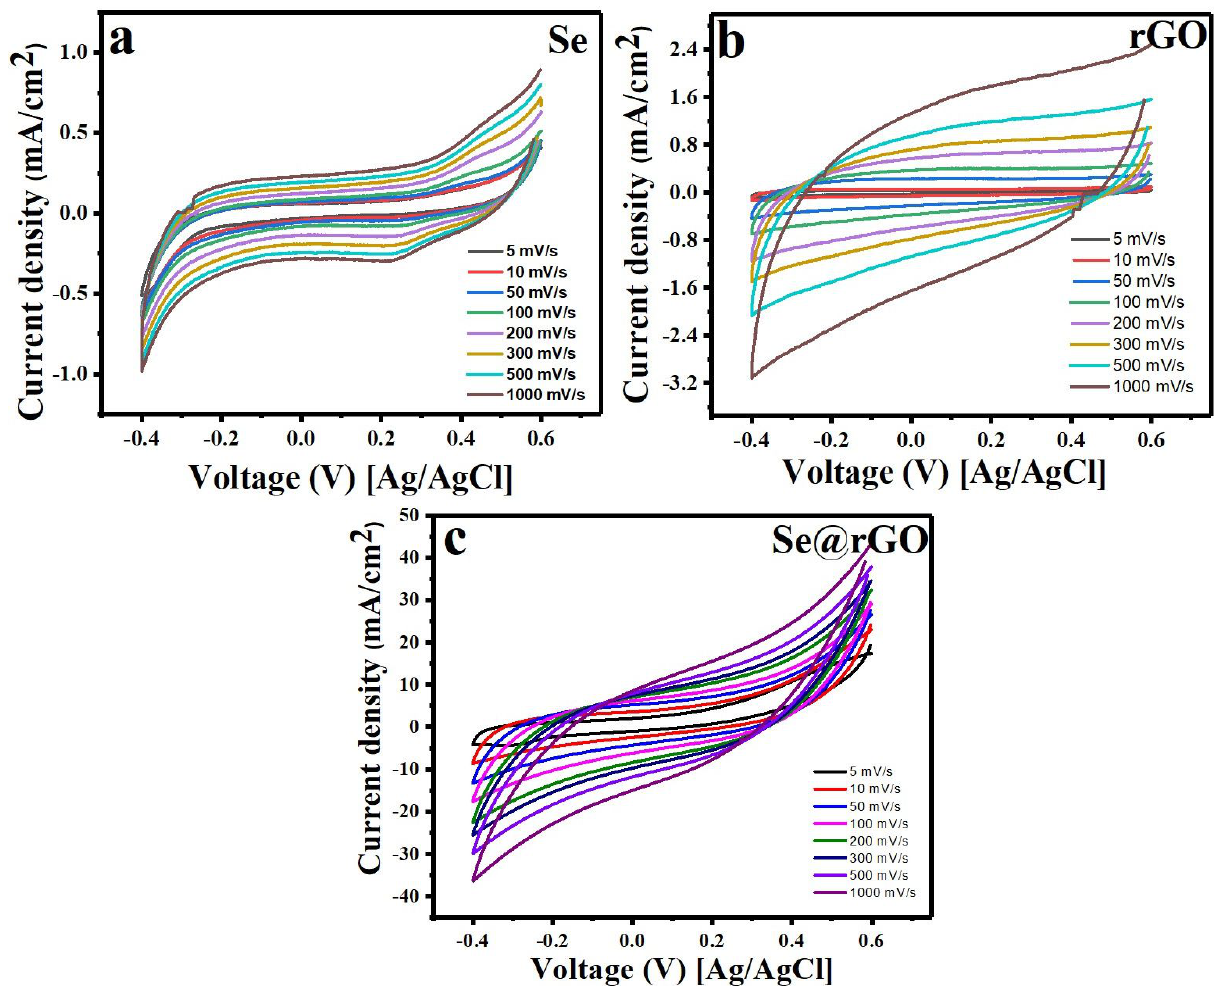
Figure 6: Cyclic voltammograms of synthesized electrode (a) Se, (b) rGO and (c) Se-nanorods/rGO nanocomposite in 1M KOH solution at different scan rates (5 to 1000